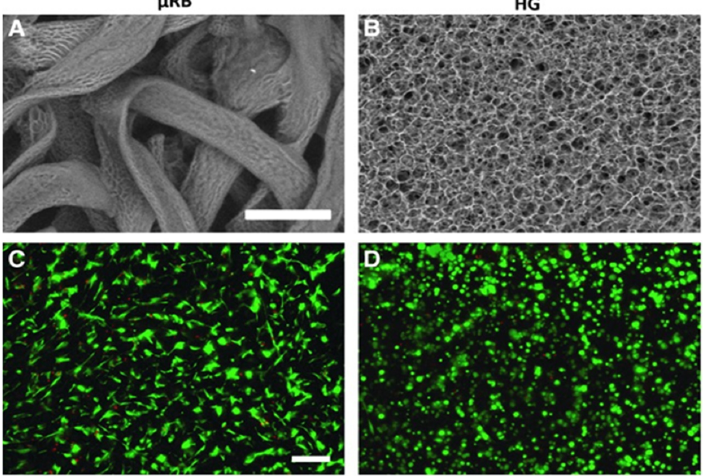
Figure 3. The macroporosity structure of ( A ) traditional HGs and ( B ) gelatin μ RB scaffolds had better MSC-based regeneration of cartilage in ( C ) rather than ( D ) Scale bar 100 μ m [107], copyright 2019.